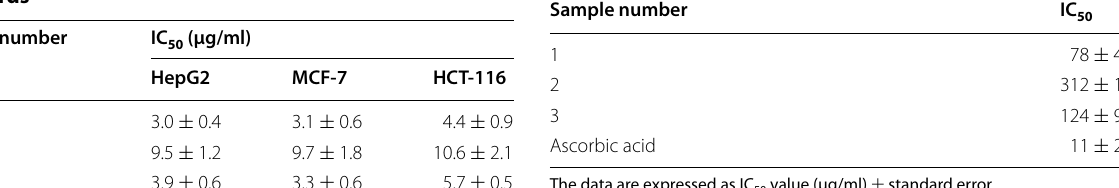
Table 1 The inhibitory activities of the tested compounds against three tumor cell lines compared with reference standards